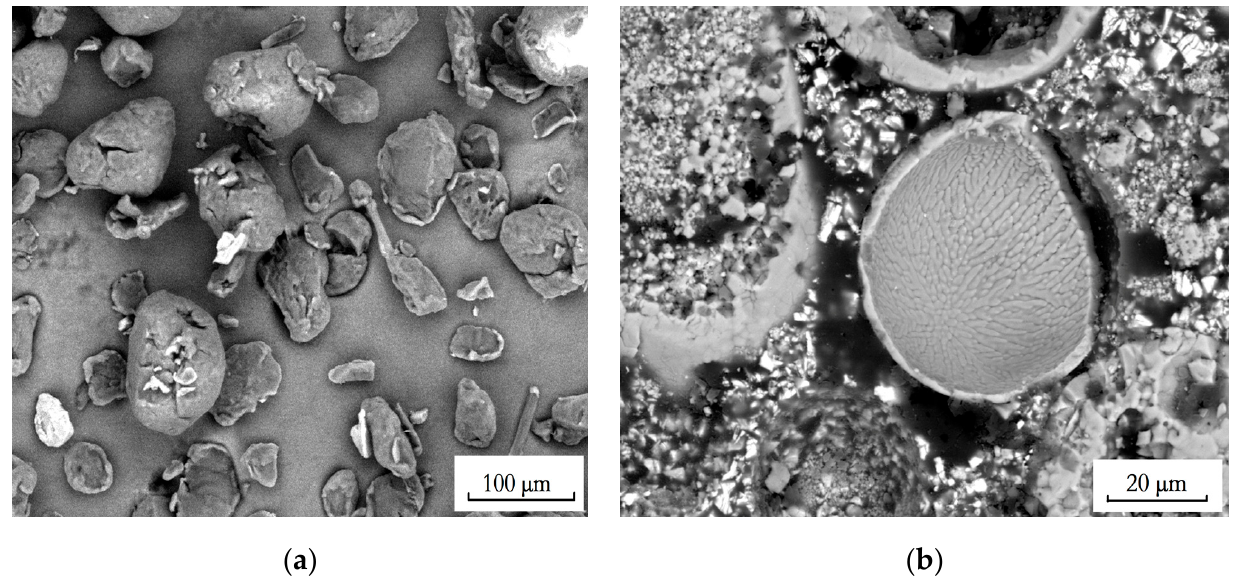
Figure 2. Microstructure of polypropylene powder: ( a ) globular; ( b ) Cross-sectional.